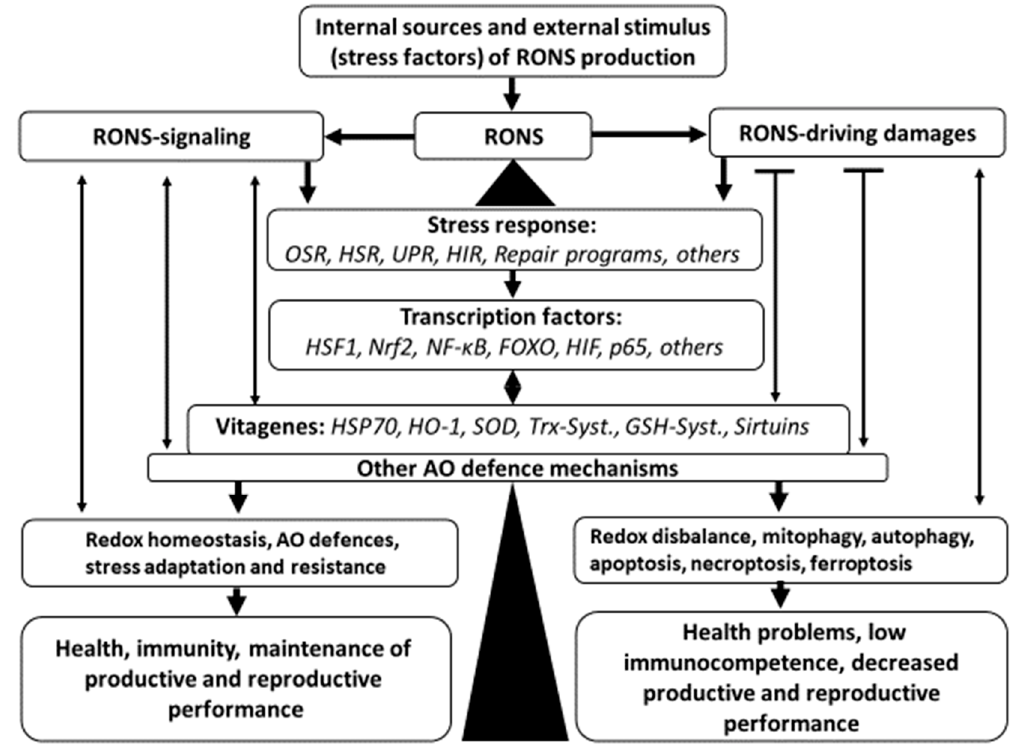
Figure 1. Antioxidant defense network in poultry (Adapted from [21]). (RONS- reactive oxygen and nitrogen species; OSR—oxidative stress response, HSR-heat shock response, UPR—unfolded protein response; HIR—hypoxia-induced response; HSF1—heat shock factor; Nrf2—transcription factor; NF-